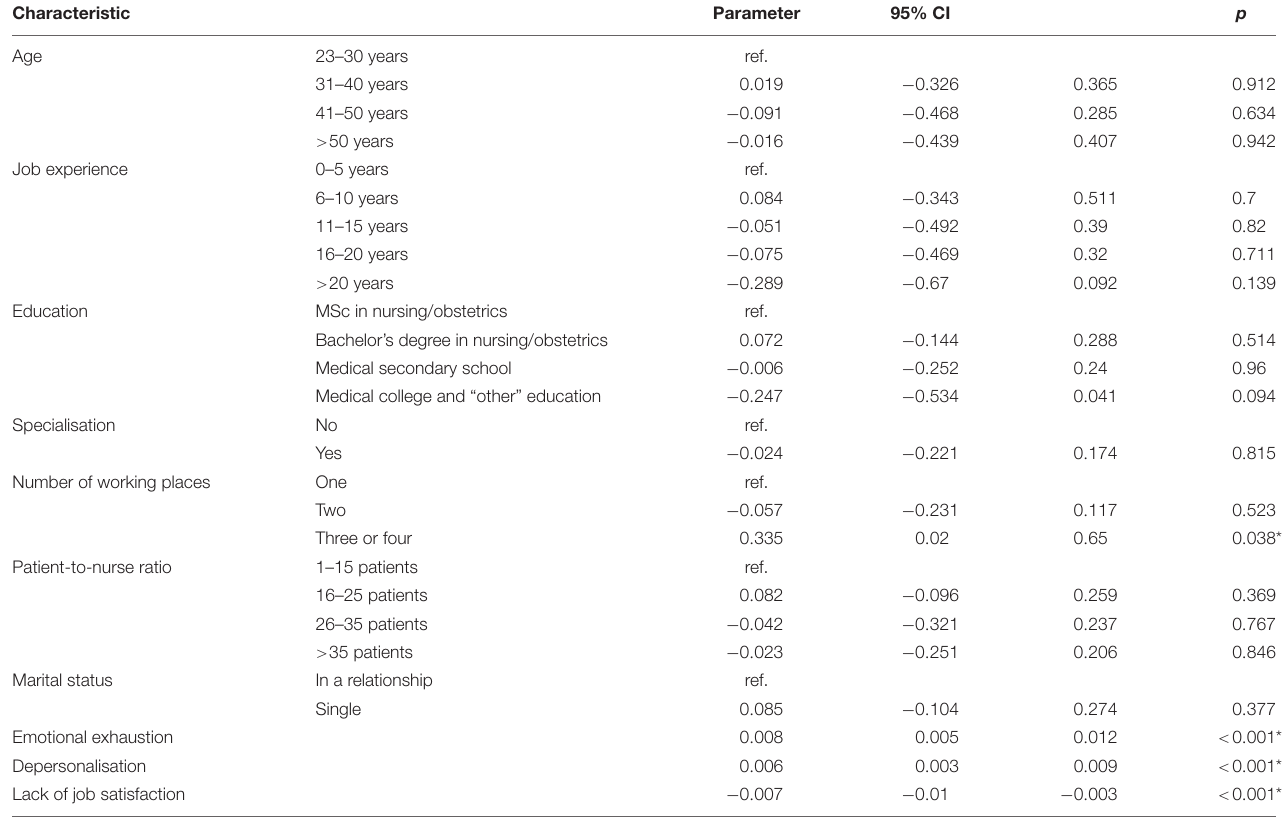
TABLE 4 | Multiple regression model of nursing care rationing for the MBI